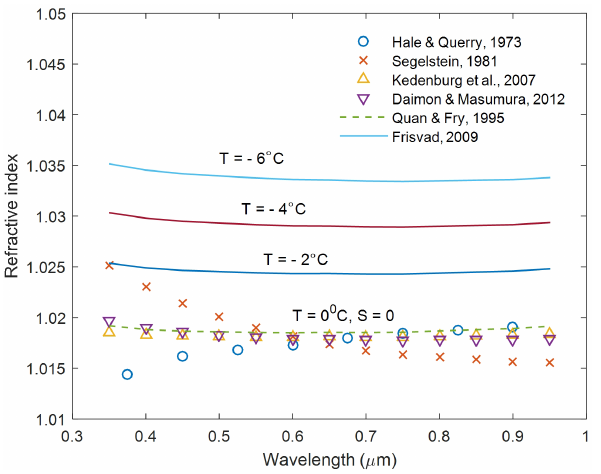
Figure 1. Spectra of the relative refractive index “water to ice”: distilled water (symbols), fresh water at 0 ◦ C (dashes), and brine with equilibrium salinity at different temperatures